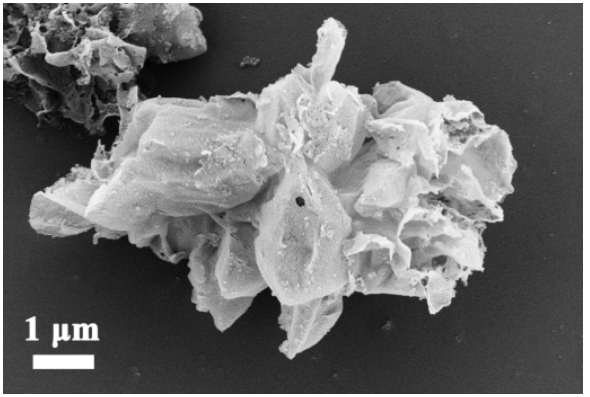
Figure 1. SEM image of g-C 3 N 4 .